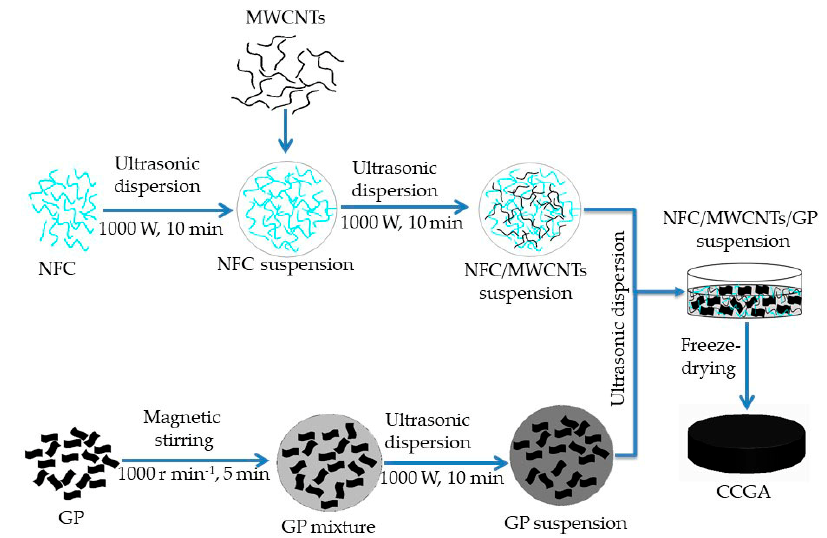
Figure 1. Scheme for preparation of the nanofibrillated cellulose/multi-walled carbon nanotubes/graphene aerogel (NFC/MWCNTs/GP) (CCGA).